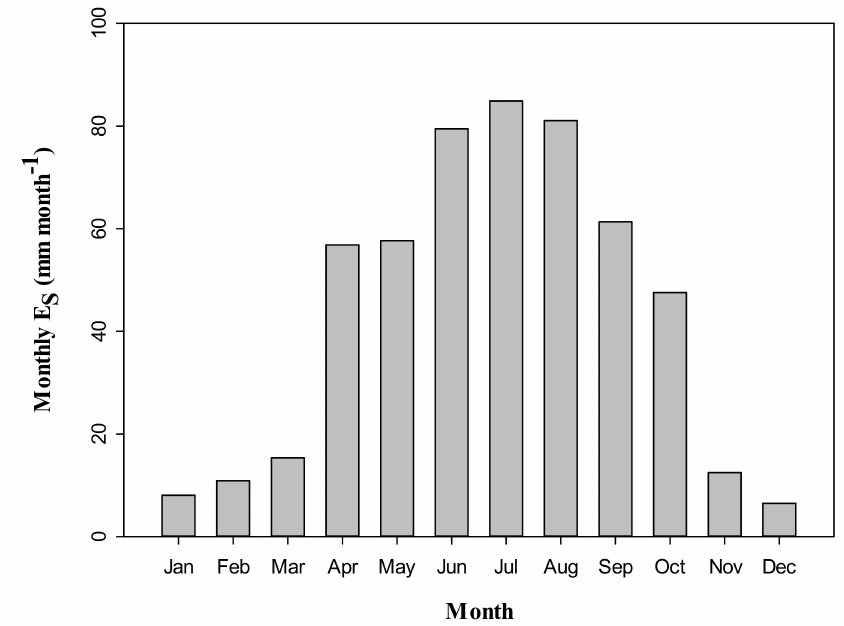
Figure 7. The cumulative monthly stand transpiration ( E s ) during the study period.